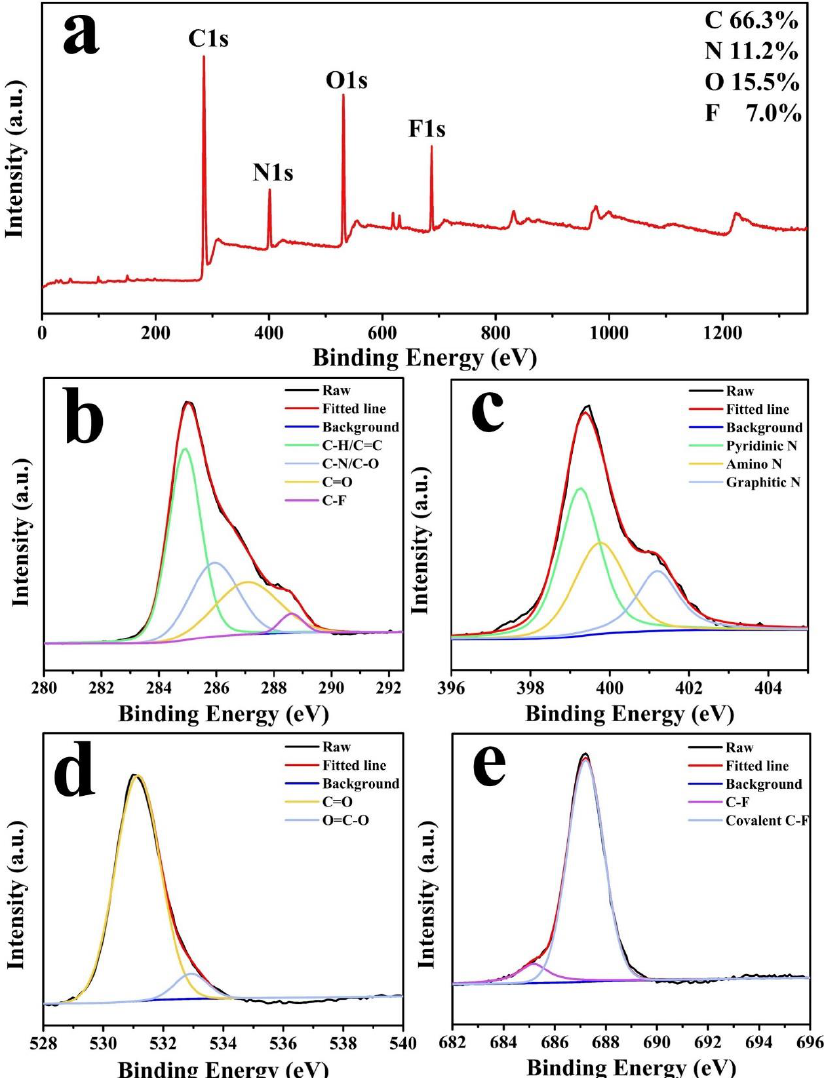
Figure 2. ( a ) XPS full profiles of N, F-CDs. High-resolution XPS spectrum of: ( b ) C1s. ( c ) N1s. ( d ) O1s. ( e ) F1s. UV-vis and fluorescence spectra were analyzed to determine the optical properties of N, F-CDs (Figure 3a). The UV-vis absorption of N, F-CDs (blue line in Figure 3a) exhib- ited an absorption peak at 230 nm, corresponding to the n –π* transition of the C=C bond. The maximum emission wavelength (red curve in Figure 3a) was located at 505 nm under a maximum excitation wavelength of 468 nm (black curve in Figure 3a). The excitation- emission map of the N, F-CDs aqueous solutions (Figure 3b), in the excitation range of 350 to 500 nm, indicated the maximum emission wavelength did not shift with changes in